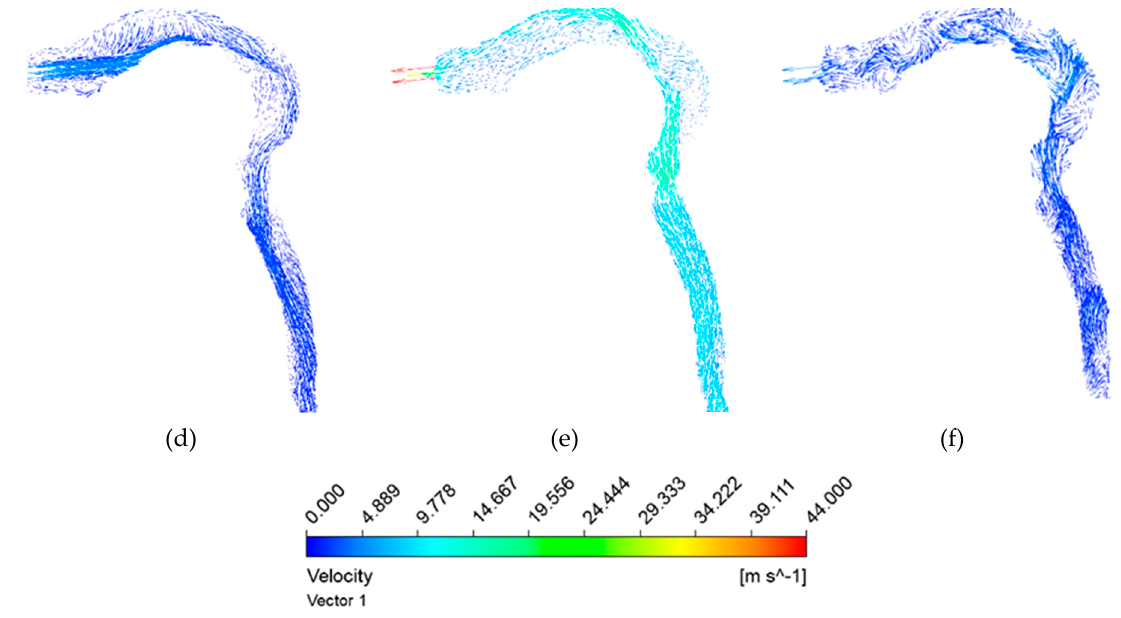
Figure 11. Airflow vector with realistic puffing waveform showing inhalation and exhalation during smoking. ( a ) At t = 0.55 s; ( b ) At t = 1.0 s; ( c ) At t = 1.5 s; ( d ) At t = 1.9 s; ( e ) At t = 2.5 s; ( f ) At t = 4.1 s.